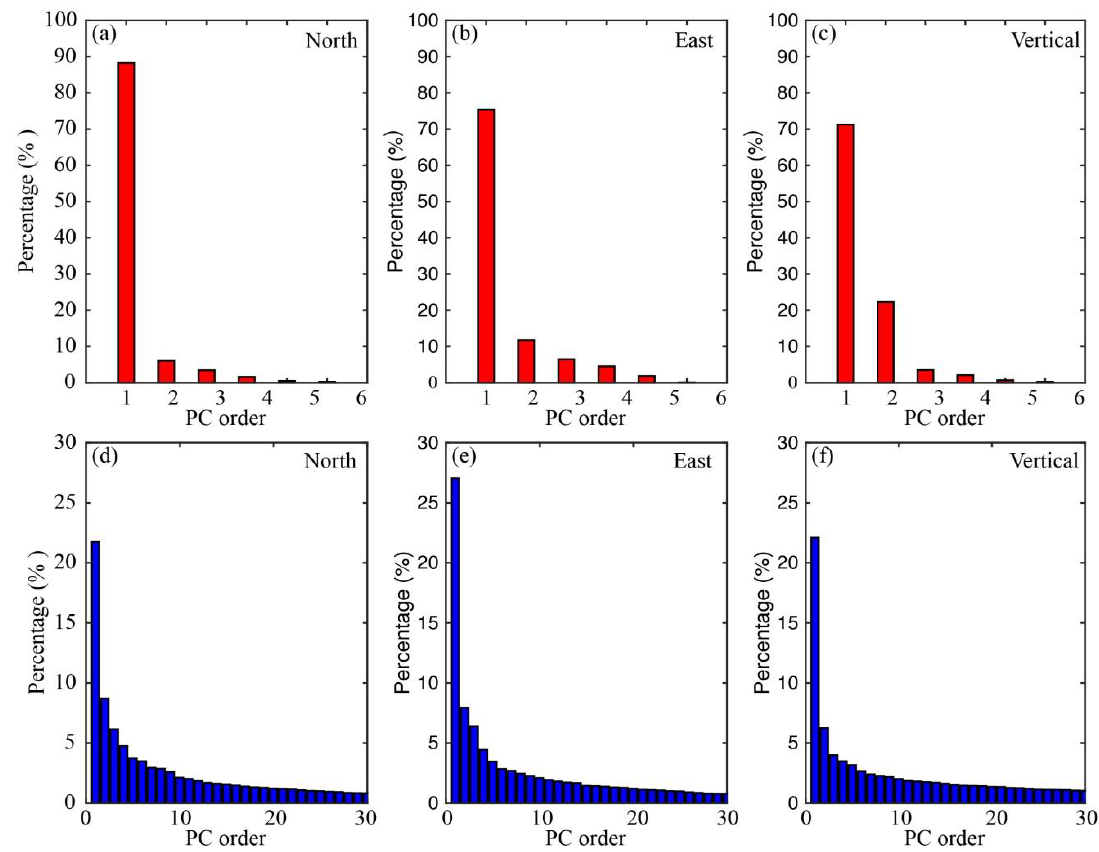
Figure 4. Histograms of the eigenvalues sorted according to the PC order on the three GPS components (North, East, and vertical). The top three histograms are the percentages of the PC eigenvalues of GPS long-term observations, while the bottom three are the percentages of the PC eigenvalues of GPS short-term observations.